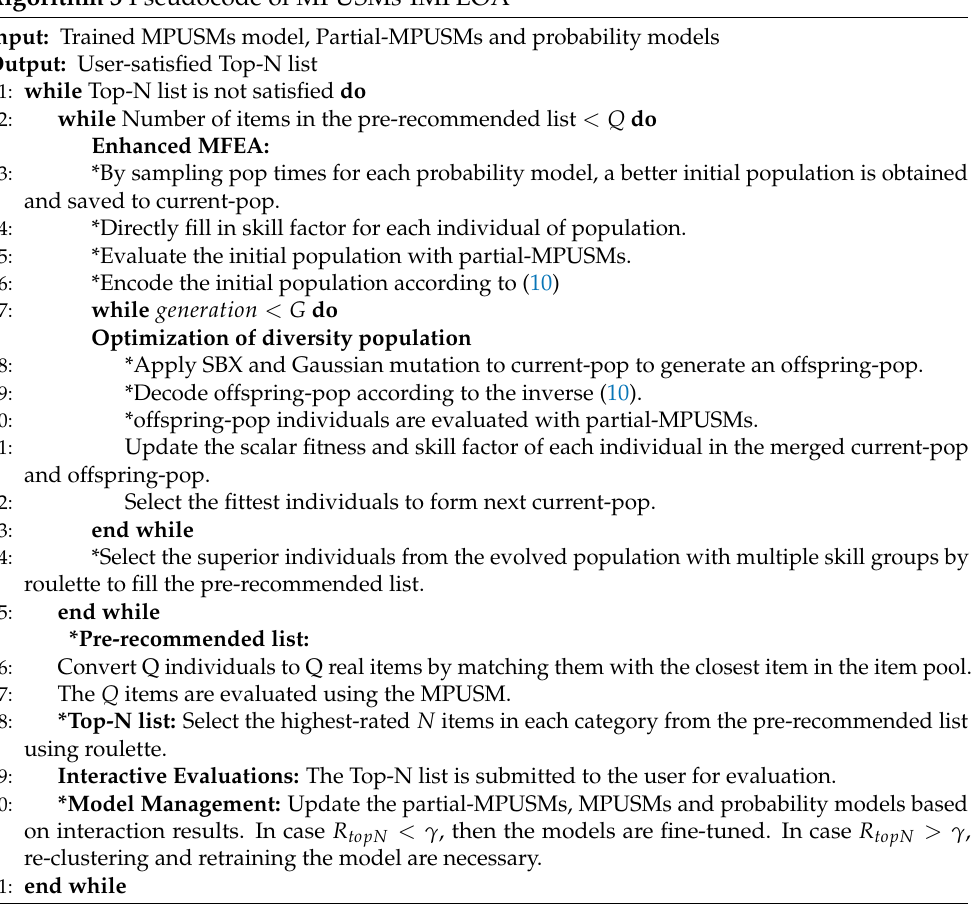
Algorithm 3 Pseudocode of